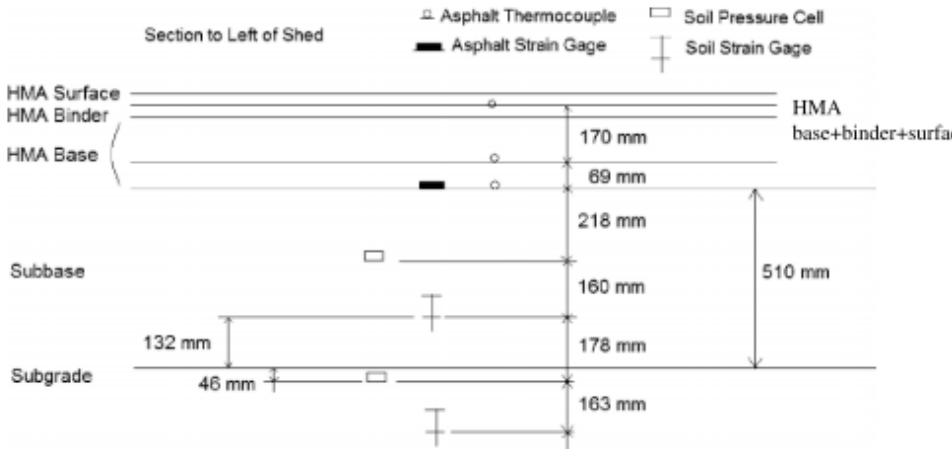
Figure 8. Layout of the instrumented section in the state of Maine (figure is reproduced from Swett et al. [31]).